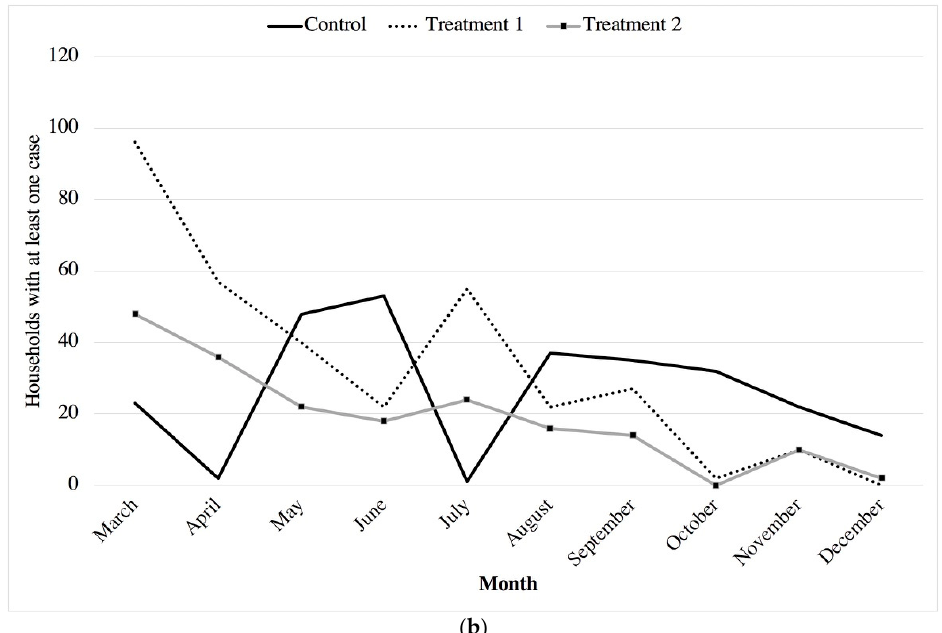
Figure 5. (a) Continuous diarrhoeal disease cases reported in terms of at least one per household (2018); ( b ) Continuous respiratory disease cases reported in terms of at least one per household (2018). Data are plotted for a child having at least one incident or infection during the month (Figure 5a,b). All health outcome graphs reflect a challenge with data from the control group occurring in the months of April and July (2018), reflective of missing diaries misplaced by the group coordinator.